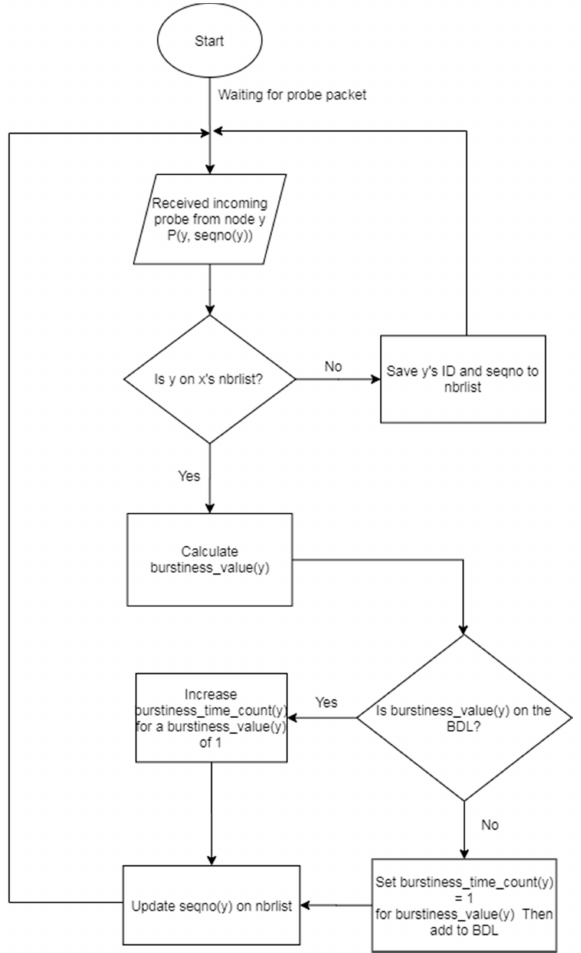
Figure 3. The flowchart of the main procedures in Algorithm 1.